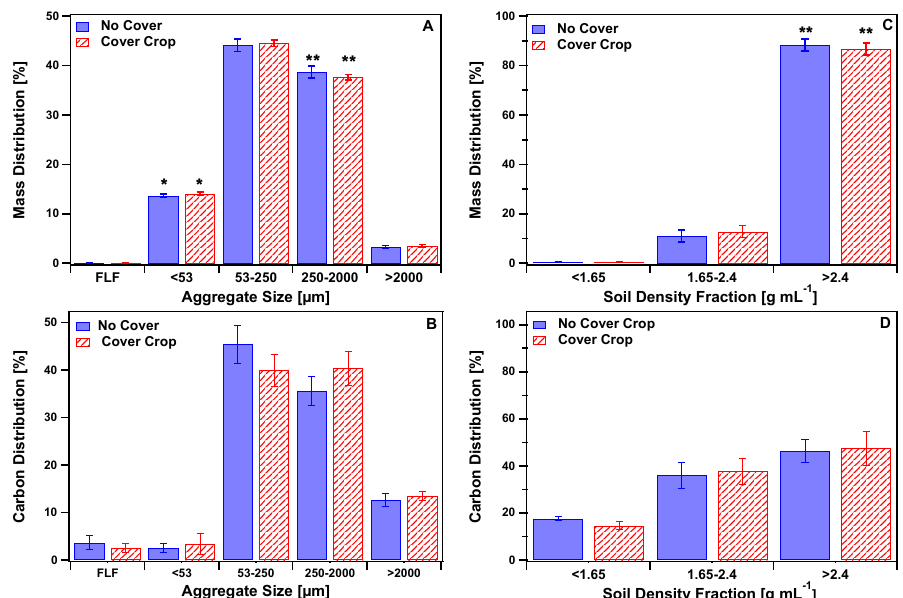
Figure 1. ( A ) Mass distribution in size separated aggregates; ( B ) carbon distribution in size separated aggregates; ( C ) mass distribution in density separated aggregates; ( D ) carbon distribution in density separated aggregates. Error bars represent ± standard error. FLF is the free light fraction. Asterisk represent p values according to the following: * ( p < 0.1); ** ( p < 0.05).